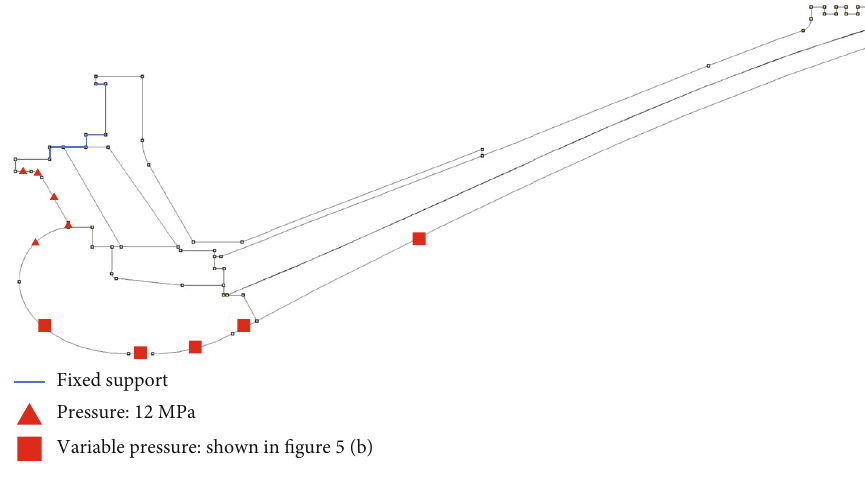
Figure 7: Structural boundary sketch.